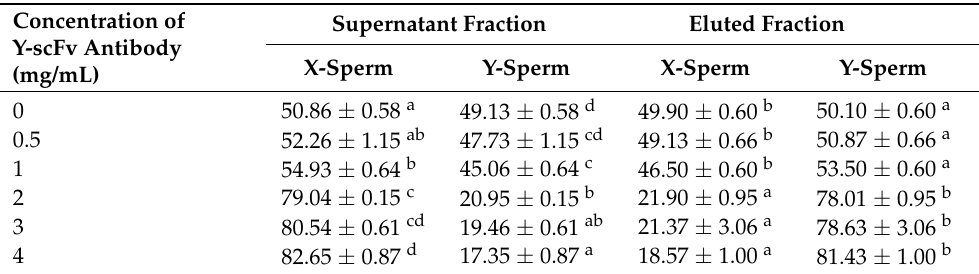
Table 2. Percentage of X- and Y-sperm expressed in each fraction produced by different concentrations of Y-scFv antibody coupled to PLA-M microbeads (mean ± SD). Concentration of Y-scFv Antibody